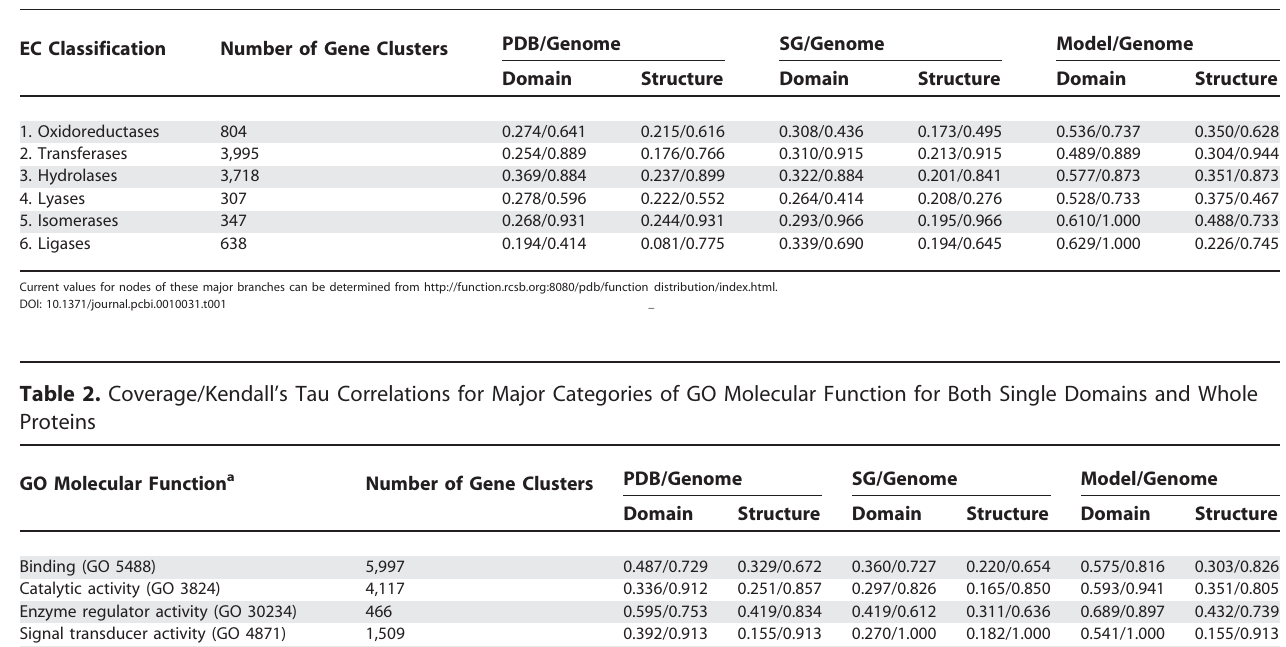
Table 1. Coverage/Kendall’s Tau Correlations for Major Categories of Enzyme for Both Single Domains and Whole Proteins